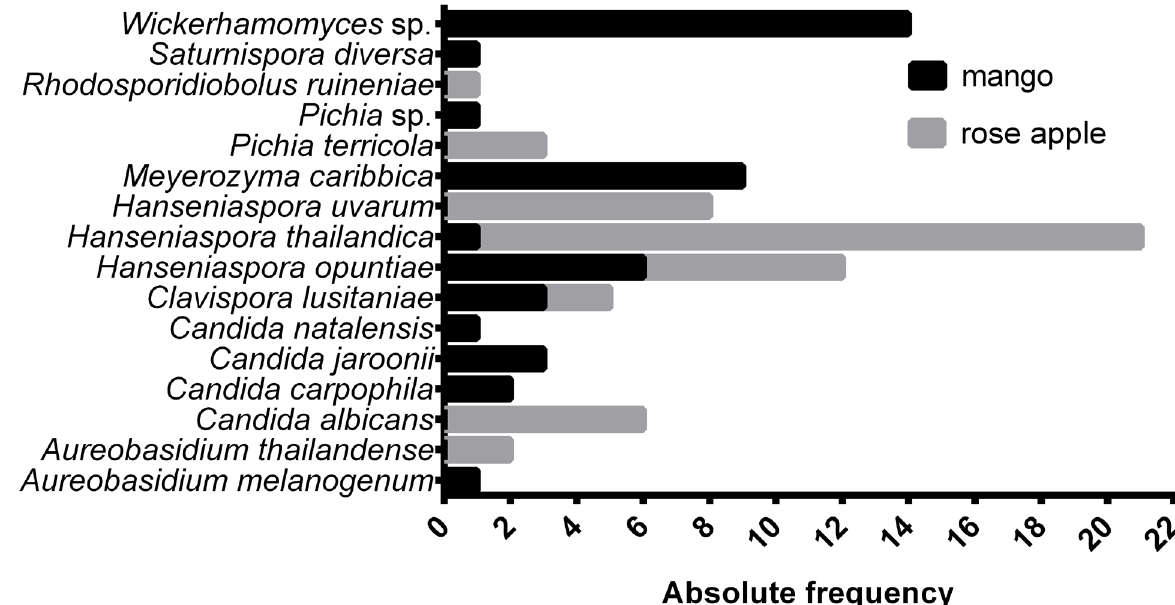
Figure 1 - Absolute frequency of yeast species obtained from mango and rose apple pulps. each value corresponded to the sum of the strains isolated for each